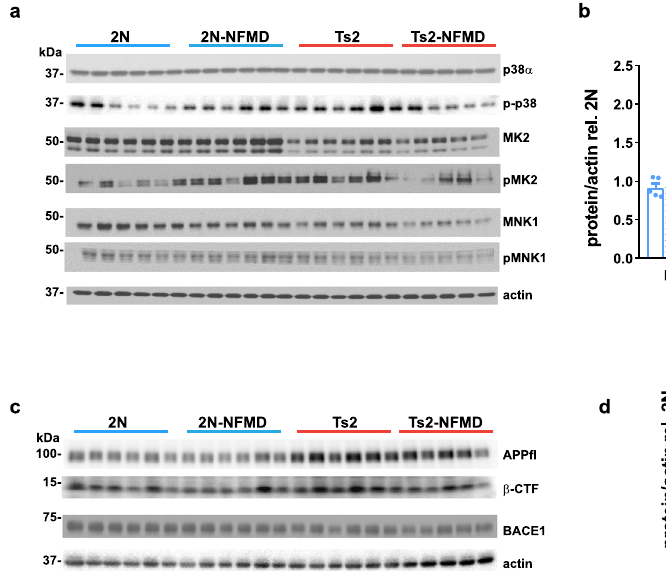
vs 2N-NFMD p =0.023, 95% CI=0.0393, 0.472, for Ts2 vs Ts2-NFMD, p =0.0347, 95%CI=0.0197,0.473;ForpMNK1F(3,19)=6.285,Rsquare=0.498,for2NvsTs2- k NFMD, p =0.0063, 95% CI=0.156, 0.824; for TS2 vs Ts2-NFMD p =0.0428, 95% CI=0.125, 0.681]. c , d Subsequent western blot analysis for full length APP (APP fl ), APP- β CTF and BACE1 and western blot image quanti fi ed with Image J and graphed with GraphPad Prism 8.0.1 (Ordinary One-Way ANOVA, For APP fl F(3, 19)=23.33,R square=0.786, for 2N vs Ts2, p <0.0001, 95% CI= − 684, − 0.376; for 2N vs Ts2- NFMD p =0.0001, 95% CI= − 0.532, − 0.209; For APP- β CTF F(3, 19)=8.167, R square=0.563, for 2N vs Ts2, p =0.0003, 95% CI= − 1.027, − 0.367; for Ts2 vs Ts2- NFMD p =0.0007, 95% CI=0.3187, 1.010; For BACE1 F(3, 19)=12.86, R square= 0.670,for2NvsTs2-NFMD, p =0.0001,95%CI=0.158,0.491;forTs2vsTS2-NFMD p =0.0469, 95% CI= − 0.00185, 0.335). Data are presented as mean values ± SEM. Statistical signi fi cance is represented by asterisks * p ≤ 0.05, ** p ≤ 0.01, *** p ≤ 0.001. Source data are provided as a Source Data